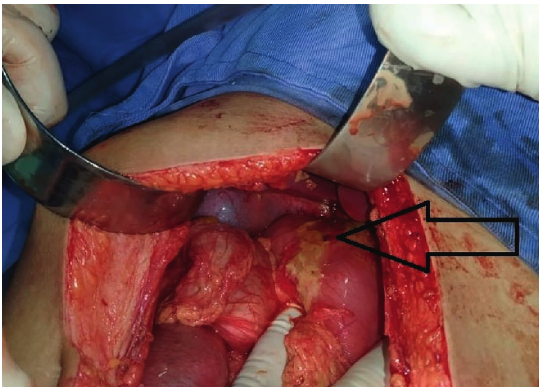
Figure 2: D1 perforation at laparotomy.